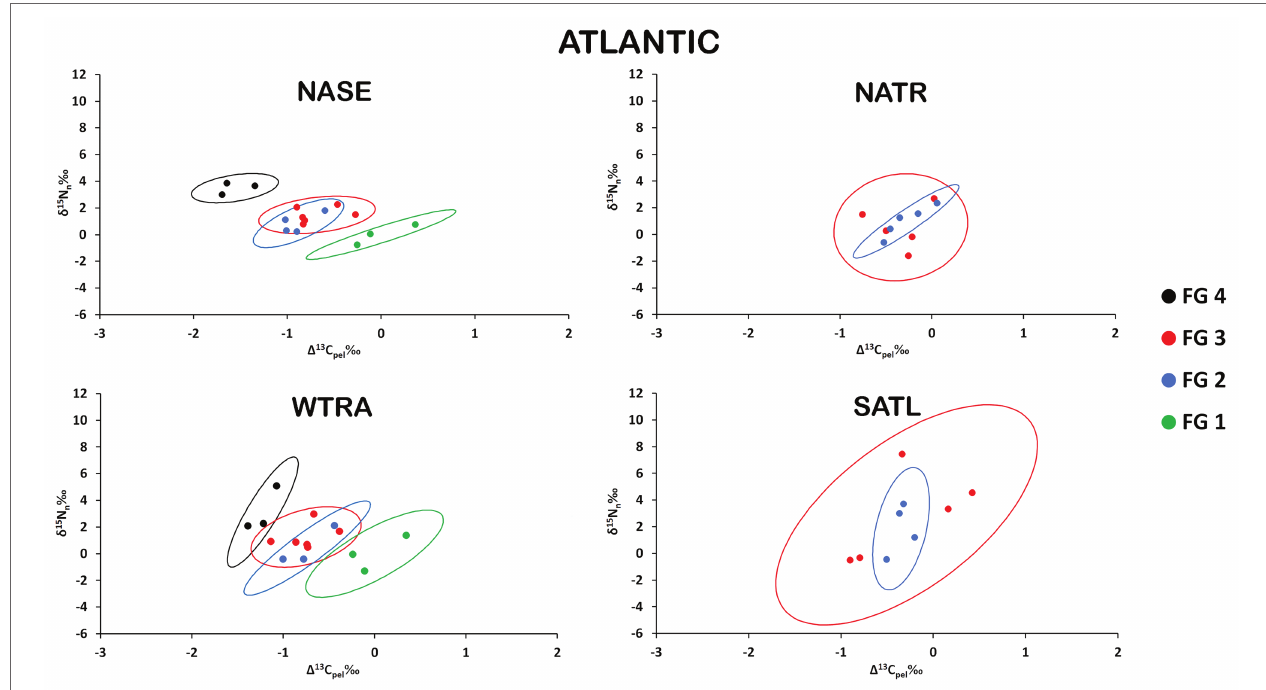
FIGURE 3 | Isospace of Δ 13 C pel and δ 15 N n including individual sample normalized values of neustonic zooplankton for biogeochemical provinces in the Atlantic Ocean: NASE, NATR, WTRA, and SATL. The maximum likelihood estimates of the standard ellipse areas (thick lines) for each functional group (FG) are shown. FG 1 = detritivores; FG 2 = herbivores/omnivores; FG 3 = carnivores; FG 4 = predators. Decreases in Δ 13 C pel reflect increases in raw δ 13 C values due to